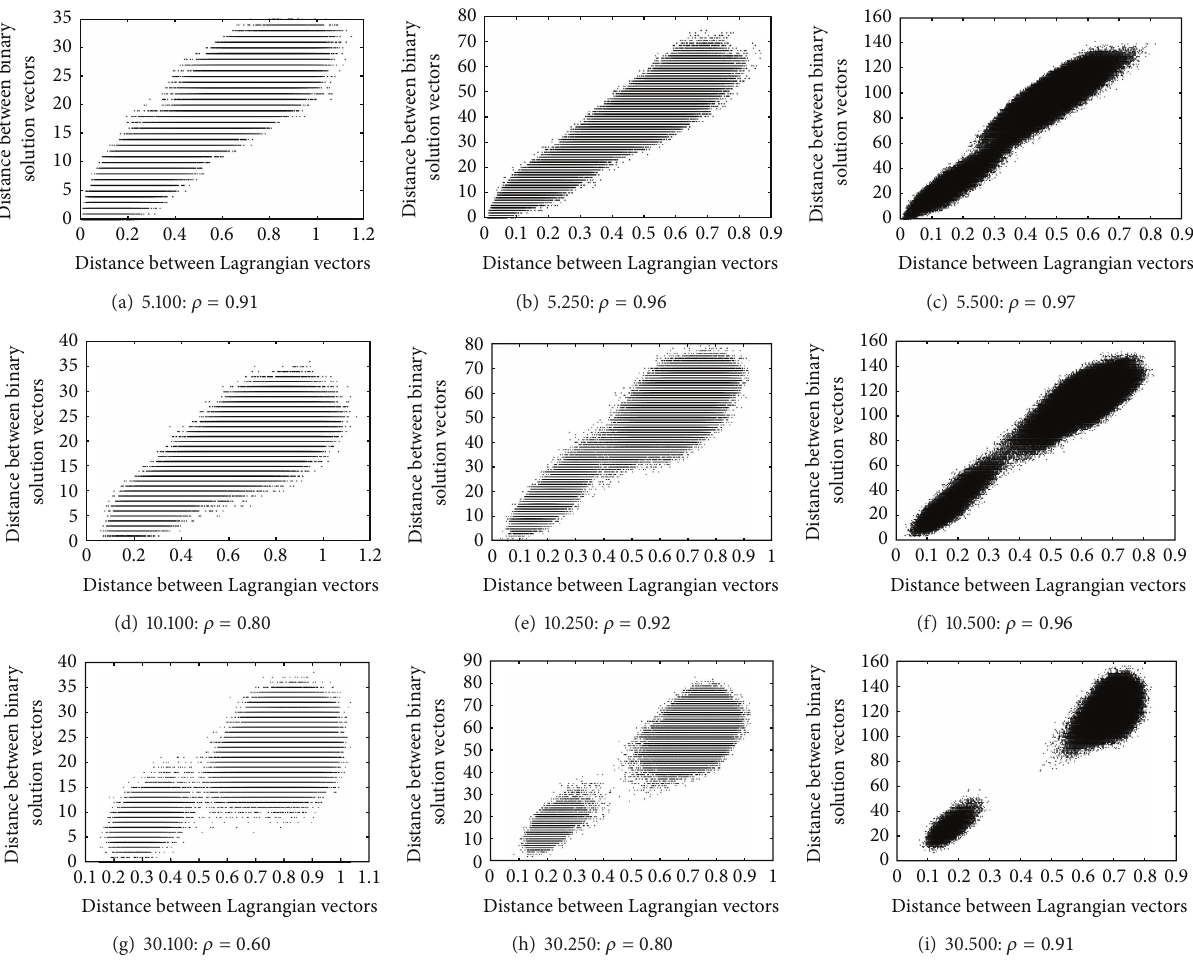
(i) 30.500: 𝜌 = 0.91